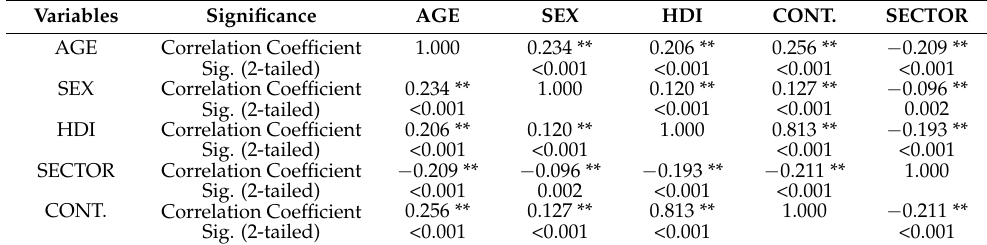
Table 13. Spearman matrix of nonparametric bivariate